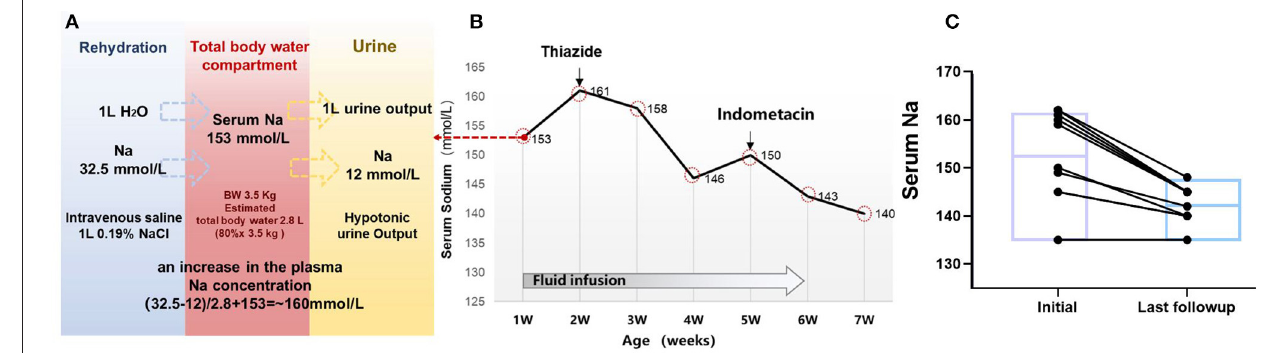
FIGURE 3 | Clinical treatment and outcome in 10 children with NDI. (A) Simplified tonicity balance for the neonate ID#3 with NDI, excreting hypotonic urine and receiving 0.19% saline. When considering separately the balances for water and Na, the excess Na administration from 0.19% saline becomes immediately obvious. The red box in the middle represents the total body water compartment of a patient with NDI. A patient with NDI excretes hypotonic urine, detected with the urine Na concentration of 12 mmol/L. If 1L of urine output is replaced with 1L of 0.19% saline, this will not change the fluid balance but lead to a net gain of 20.5 mmol of Na. In the neonate of 3.5kg with estimated 2.8L of total body water, this would lead to an increase in the plasma Na concentration of ∼ 20.5 mmol/2.8L = 7.3 mmol/L. (B) Serum sodium and treatment in the case #3. (C) Follow-up of the serum sodium level in 10 patients with treatment of thiazides and